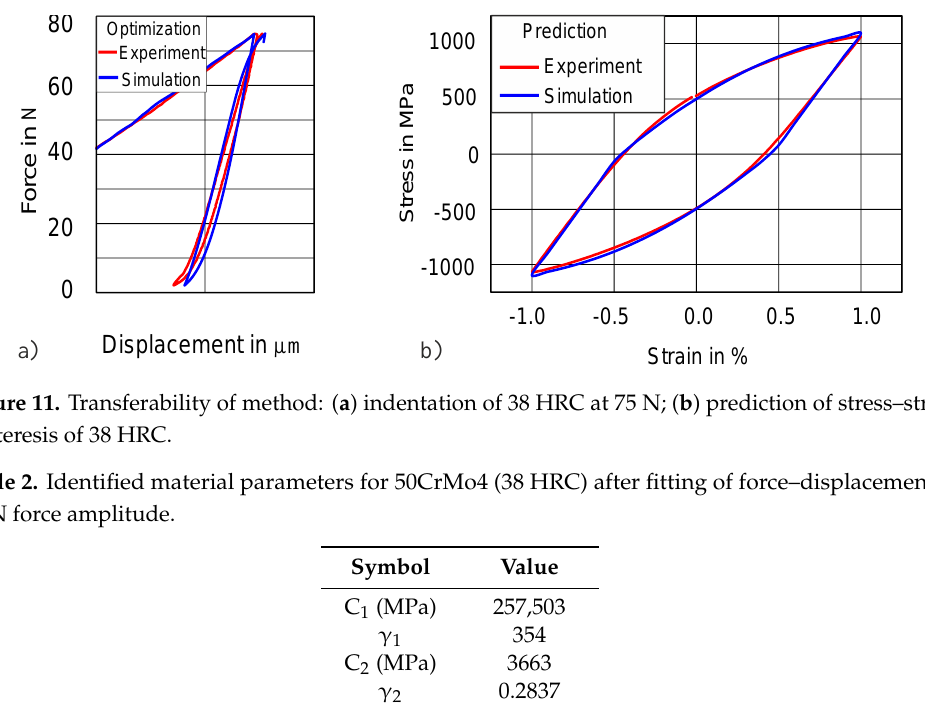
Figure 10. ( a ) Predicted uniaxial stress – strain hysteresis for the 10th cycle. ( b ) Stress amplitude over the number of cycles for the first 10 cycles.